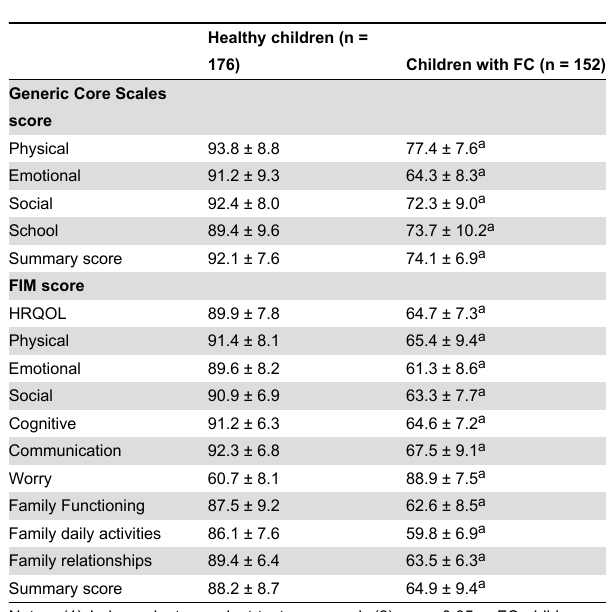
Table 3. Mean scores ( x ± s ) of caregiver proxy-report on the Generic Core Scale and FIM